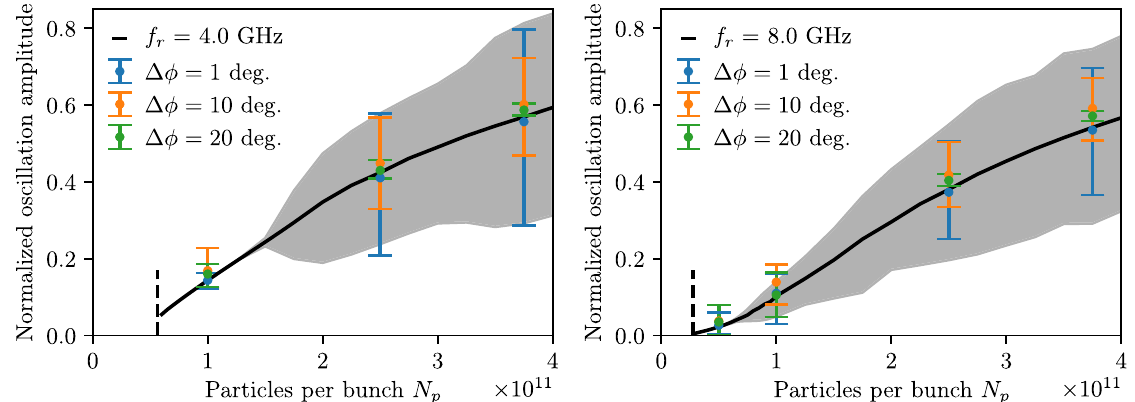
FIG. 15. Normalized average amplitude of residual oscillations after a kick of different amplitudes obtained from BL on D macroparticle simulations (color points) and from MELODY using Eq. (62) (black curves) for different bunch intensities above the LLD threshold (vertical dashed lines). The shaded gray area and error bars represent the minimum and maximum amplitudes, obtained from MELODY and BL on D , respectively. Results are for a broadband impedance with Im Z=k ¼ 0 . 07 Ω , Q ¼ 1 , f (right); zero-intensity τ 4 σ ¼ 0 . 82 ns, μ ¼ 2 , and V 0 ¼ 6 MV.